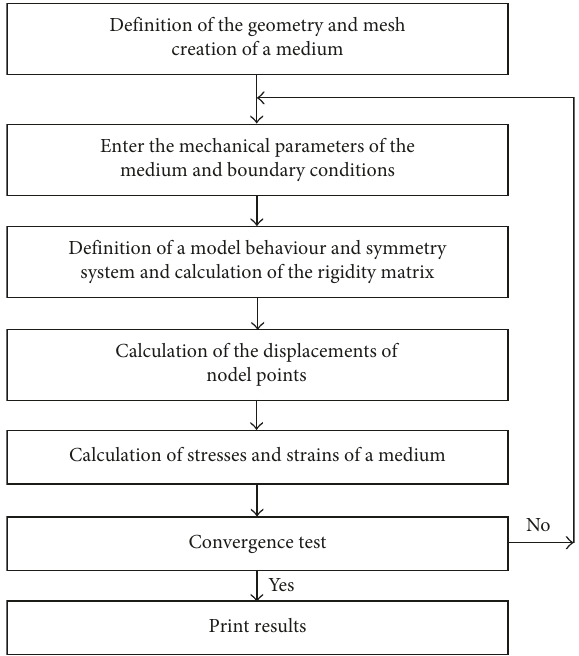
Figure 2: Algorithm of finite elements in linear elasticity